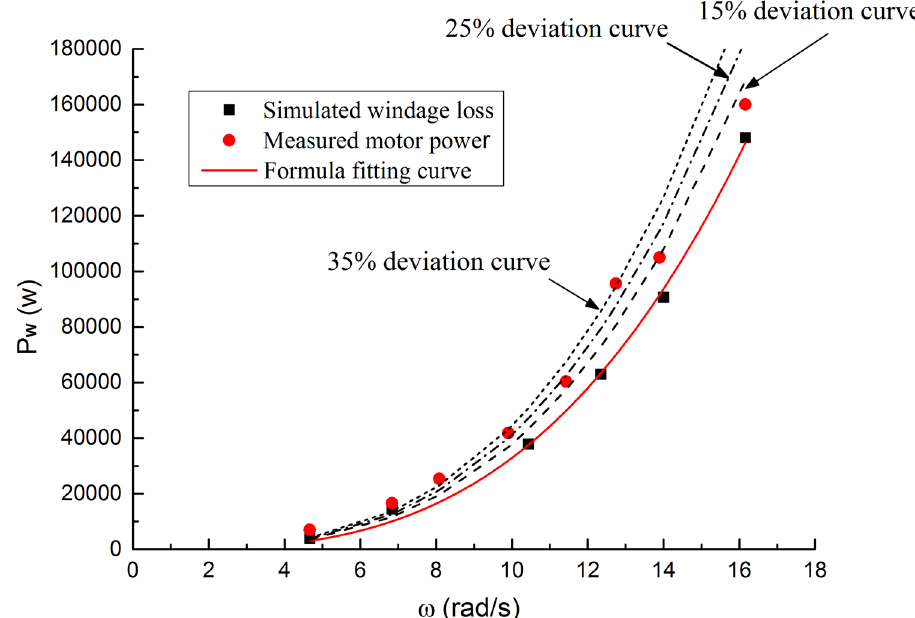
Fig. 8 Measured motor power and CFD windage